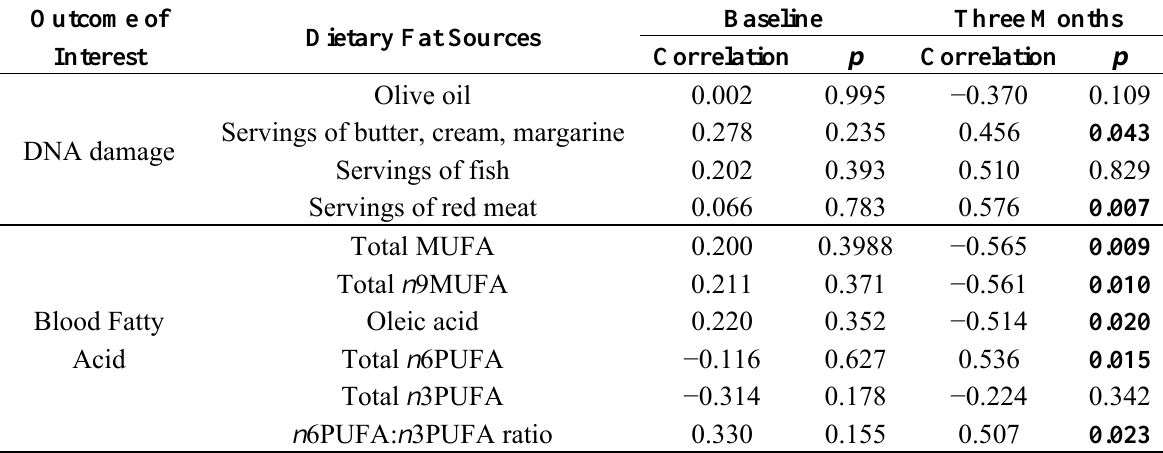
Table 5. Correlation between DNA damage and dietary fatty acid intake and blood fatty acids. Outcome